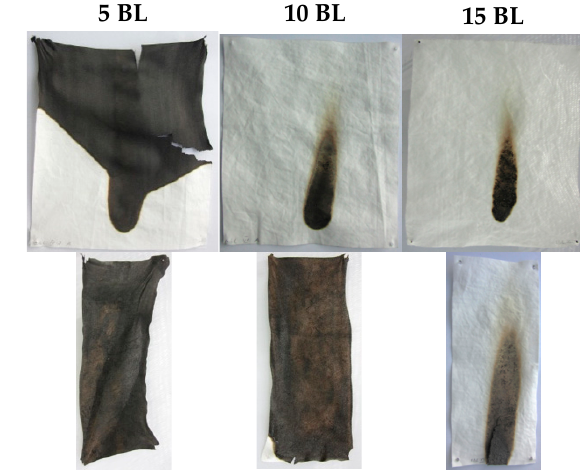
Figure 4. Coated fabrics (5, 10, 15 BL) after the flame tests, according to ISO 15025:2016 Method A and B, of surface and bottom edge ignition. Uncoated cotton fabrics burned completely down.